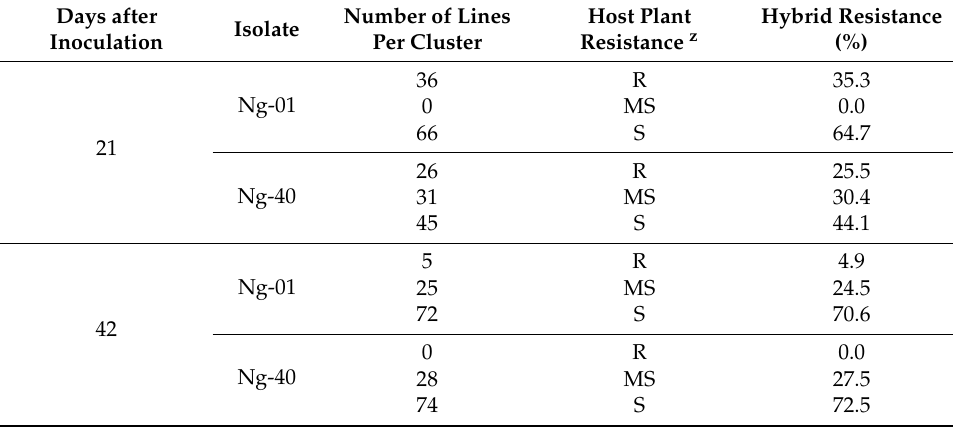
Table 7. Percentage of rice hybrids showing host plant resistance to Rice Yellow Mottle Virus strains Ng-01 and